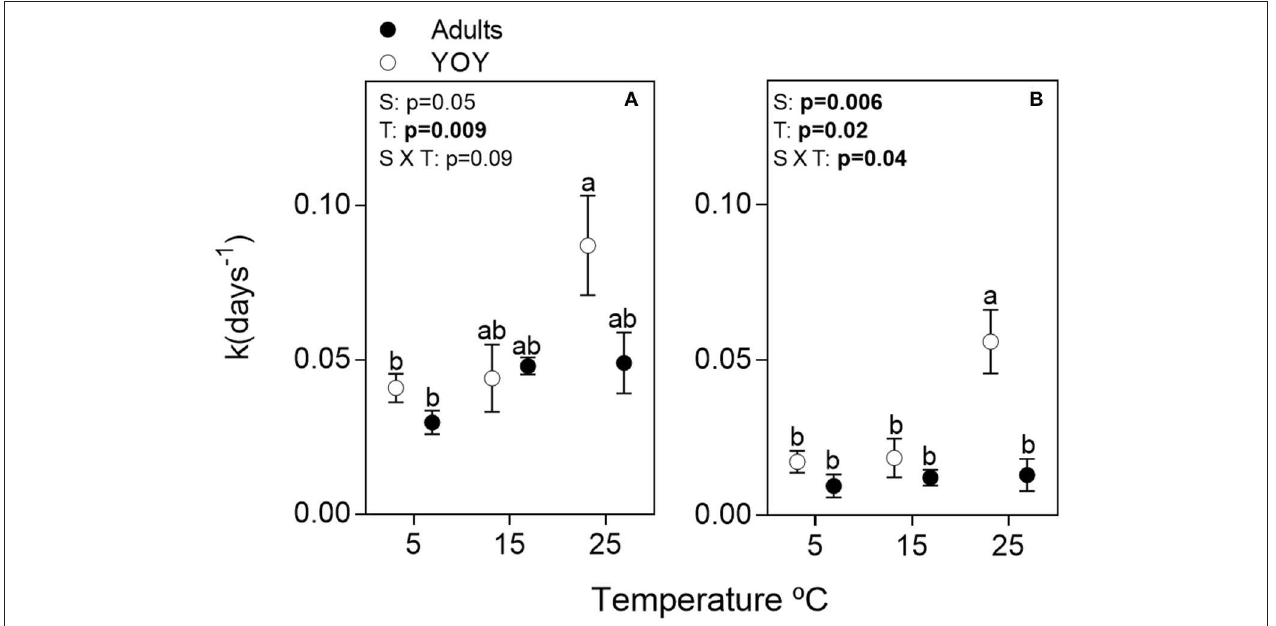
FIGURE 3 | Individual and interactive effects of fish size (S) and temperature (T) on time-integrated fish carcass decay coefficients (k) for (A) nitrogen and (B) phosphorus. Data points are means ( n = 3) and error bars are ± 1SE. Different letters above treatments indicate significant statistical differences among treatments. Bold p -values depict significant statistical effects (Tukey’s pos-hoc test; p < 0.05).